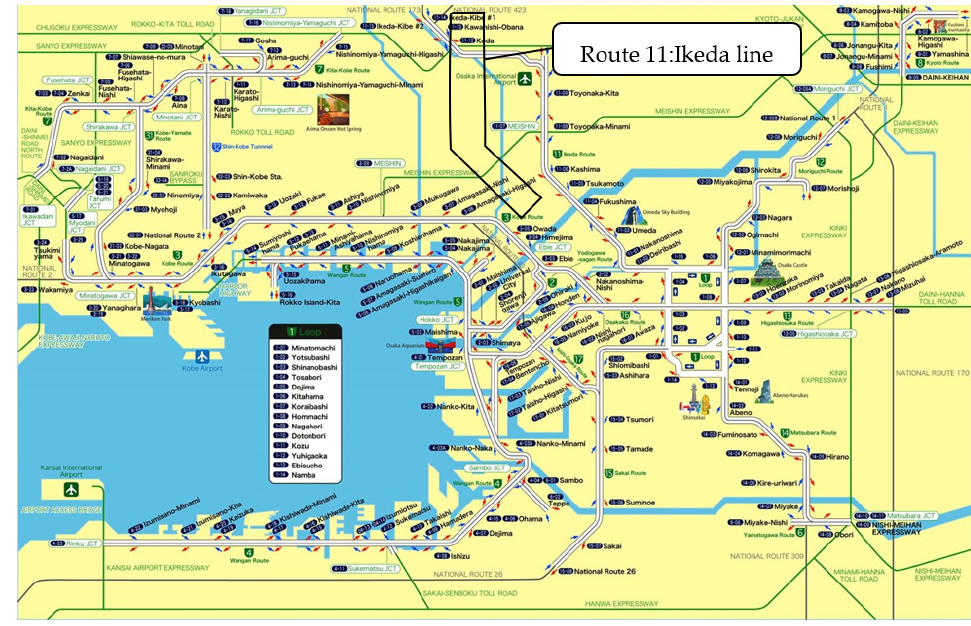
Figure 1. Hanshin expressway network.